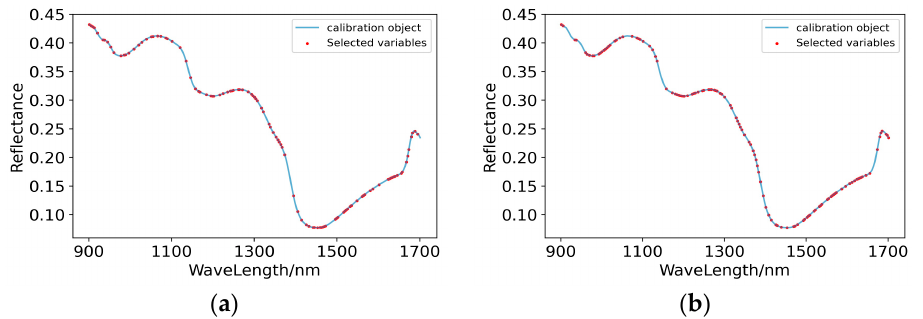
Figure 8. Characteristic wavelengths’ distribution of prediction models for the content of boron in pear pulp. ( a ) Raw-GA-PLSR; ( b ) SG-GA-PLSR. pear pulp. ( a ) Raw-GA-PLSR; ( b )